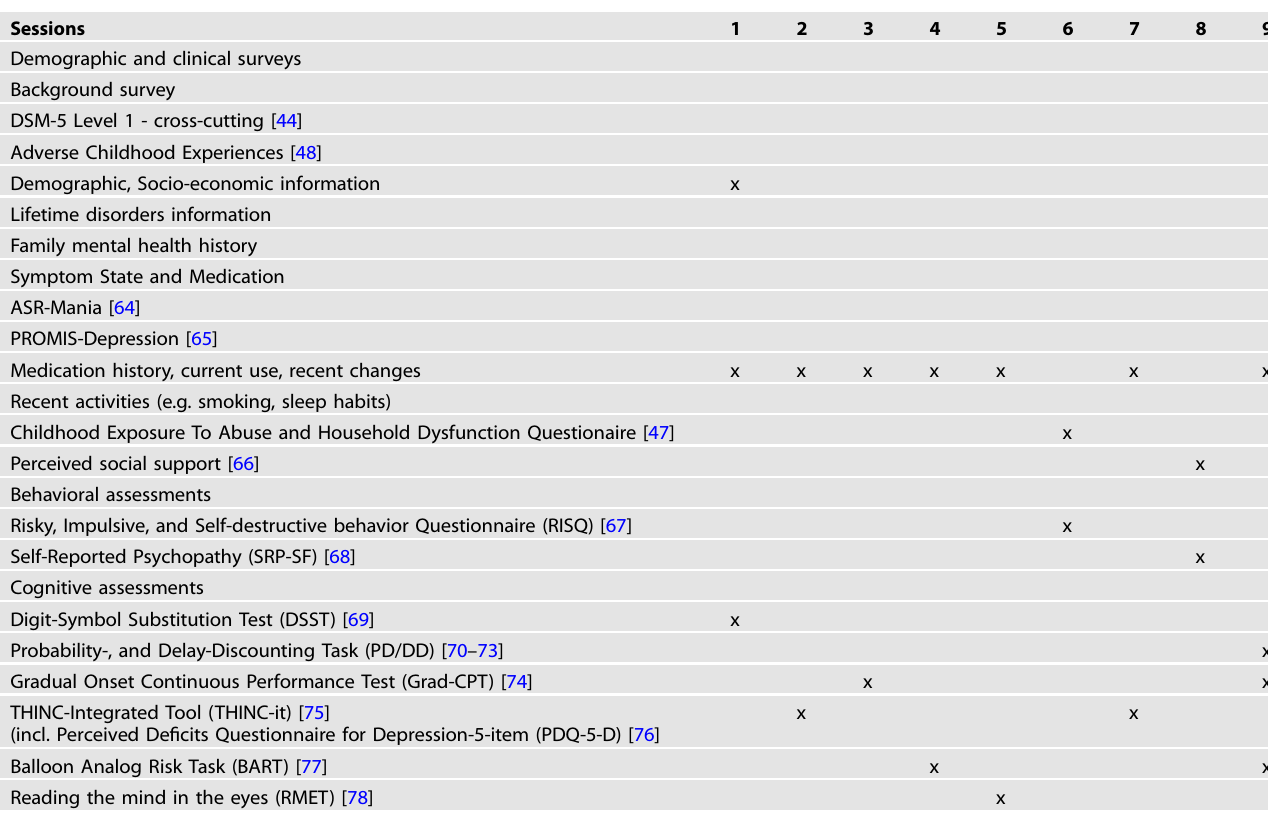
Table 1. Study content